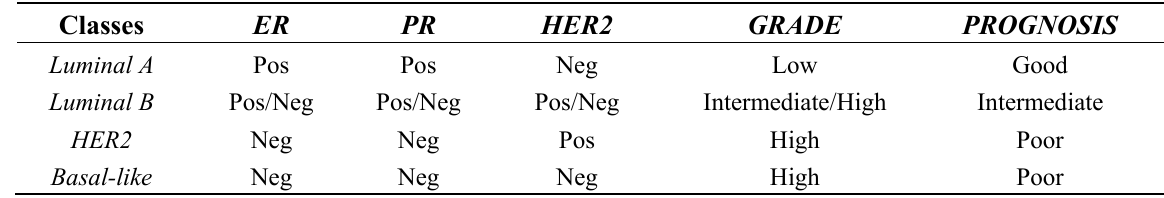
Table 1. Breast cancer classification based on gene-expression profile (GEP) characteristics [2,21].